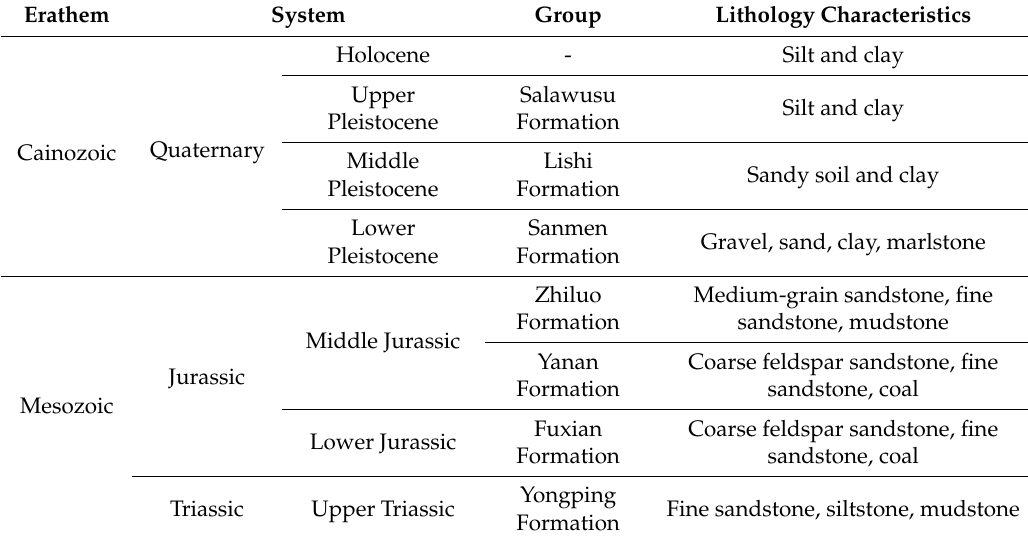
Table 1. Stratigraphy of the study area.